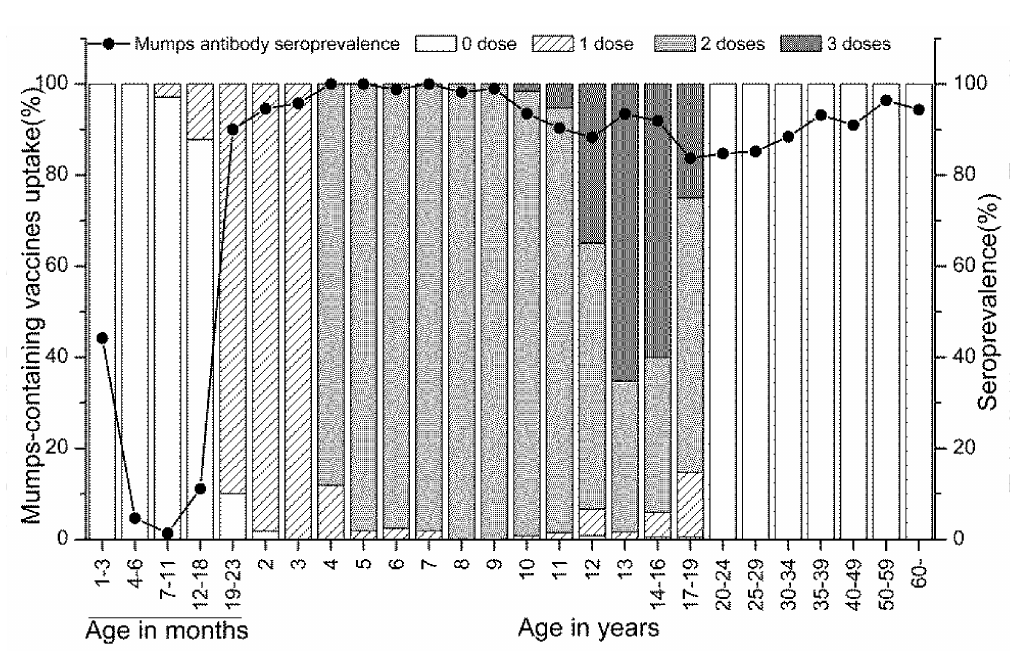
Figure 2. Doses of mumps-containing vaccines and mumps antibody seroprevalence. No (0) dose in ≥ 20 years old: no information about the vaccination status had been obtained and that some of these person might have been